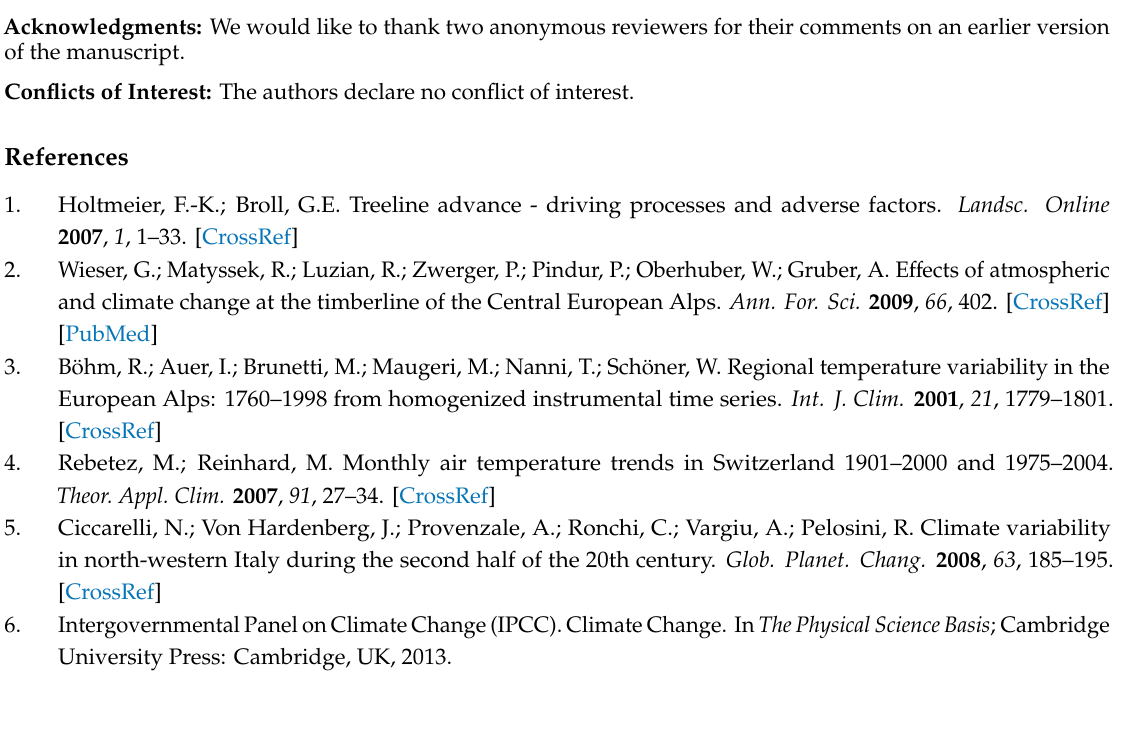
Figure S1A,B: Roof construction for experimental top-soil manipulation installed underneath the canopy around P. cembra saplings in a subalpine a ff orestation in the Sellrain Valley, Tyrol, Austria [7]. The same approach has been used in this